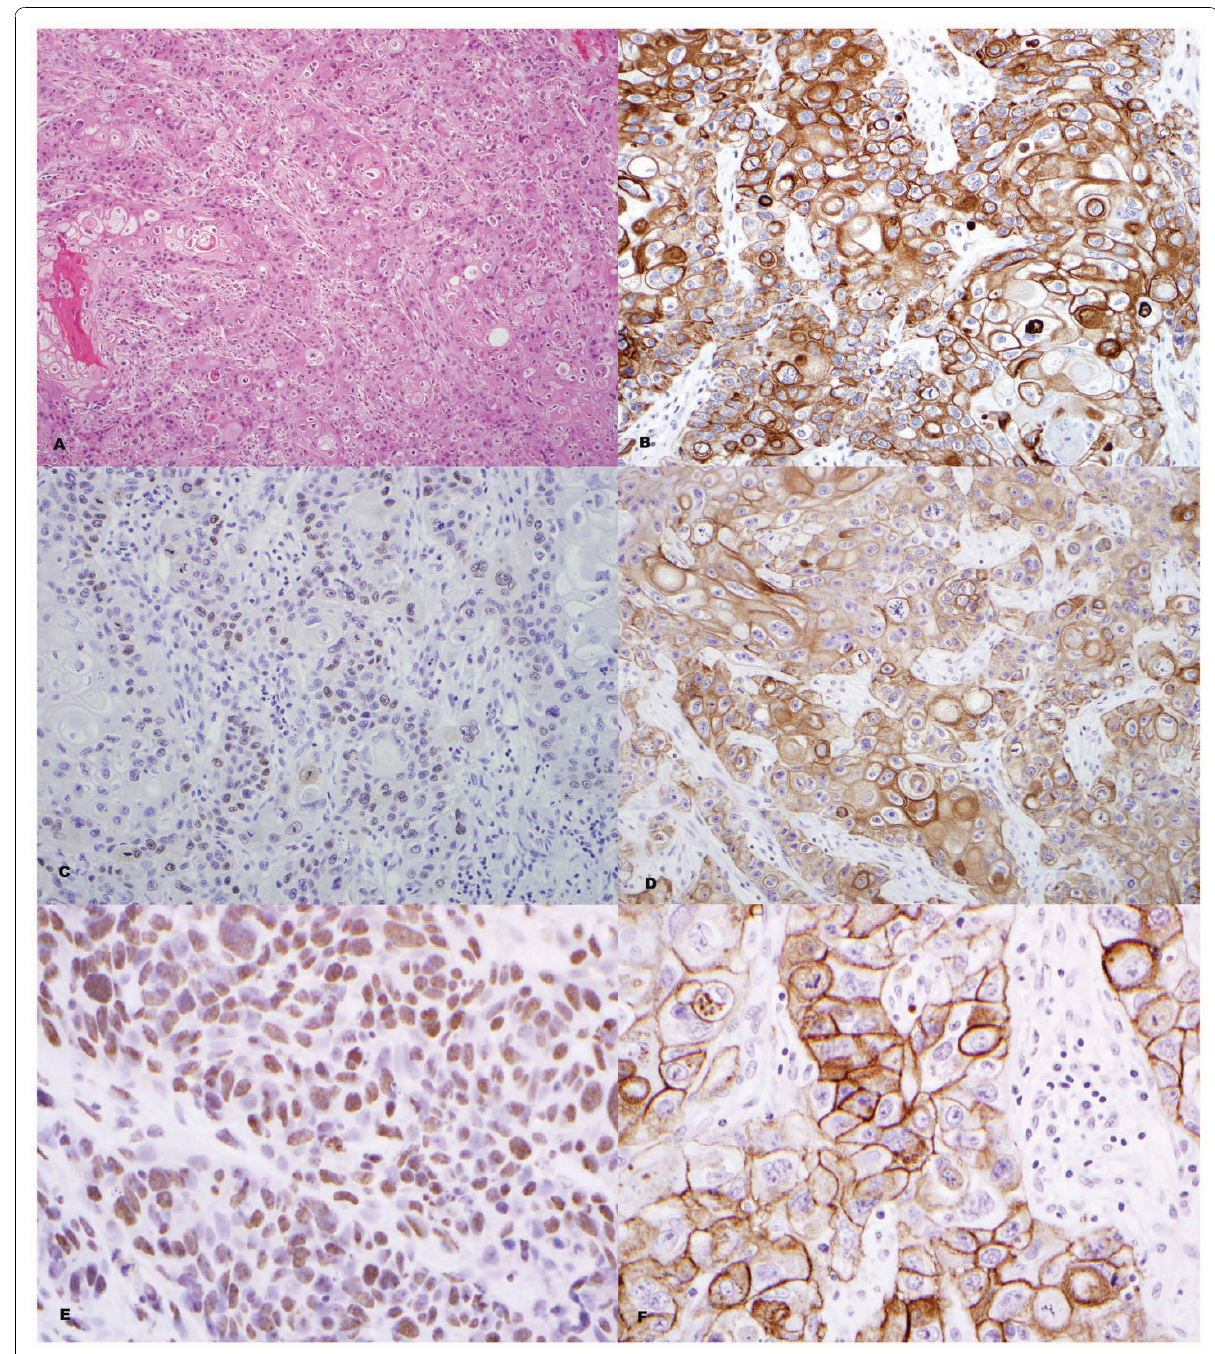
Figure 3 High grade squamous cell carcinoma (A; H&E - 40×) with positive staining for OSCAR (B; 40×), p63 (C; 40×), WS-KER (D; 40×), SNAIL (E; 60×) and EGFR (F; 60×)